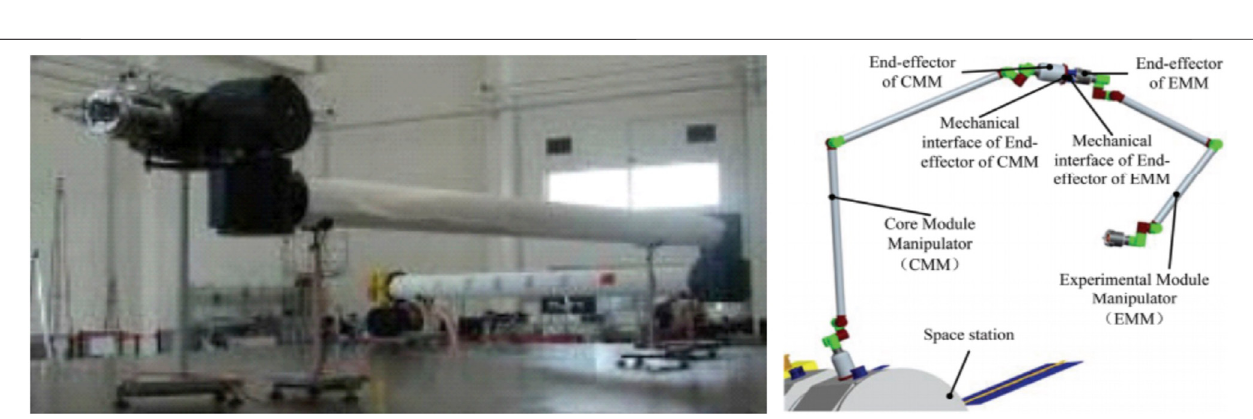
FIGURE 13 | (A) Chinese Space Station Manipulator (CSSM) (Li et al., 2015), (B) China ’ s Space Station Remote Manipulator System (CSSRMS) (Liu, 2014).